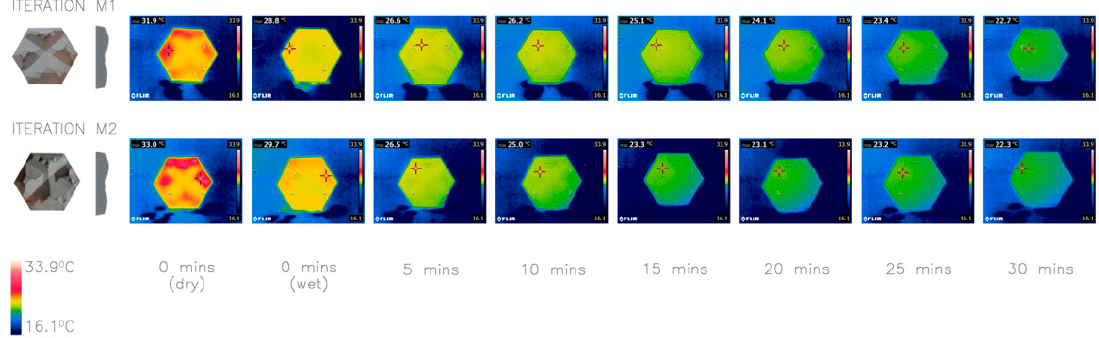
Figure 9. Thermal imaging of investigation 6: comparison of two iterations M1 and M2. Average heat loss after 30 min: M1 9.1 °C, M2 9.8 °C.